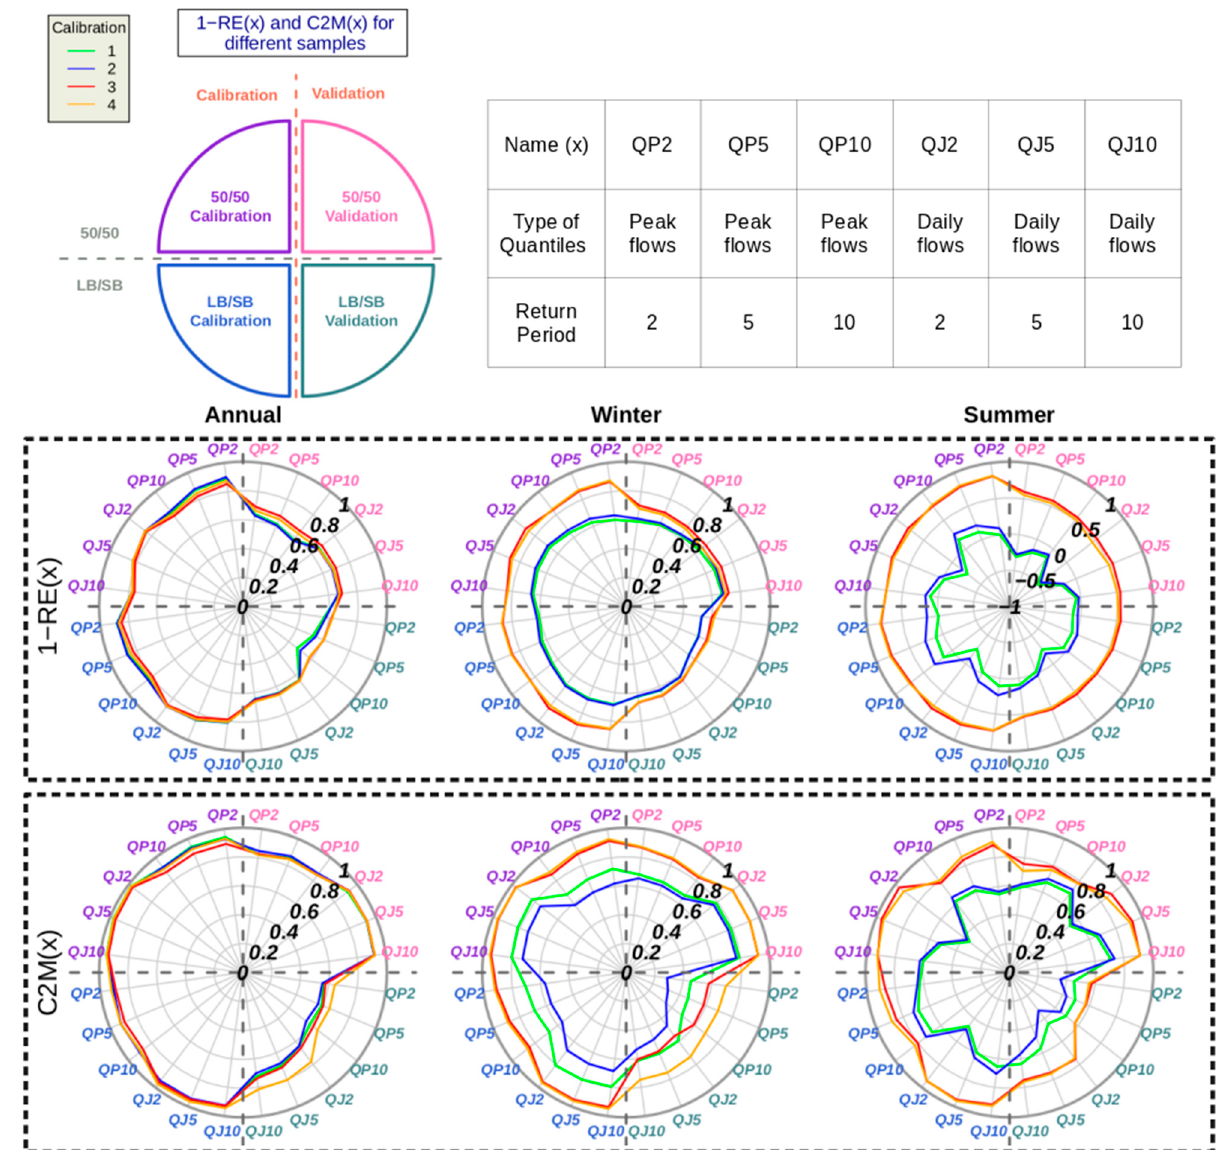
Figure 6. “Spatial” criteria calculated for both calibration and validation catchments and for two samplings, based on observed annual/winter/summer flow quantiles displayed from left to right.